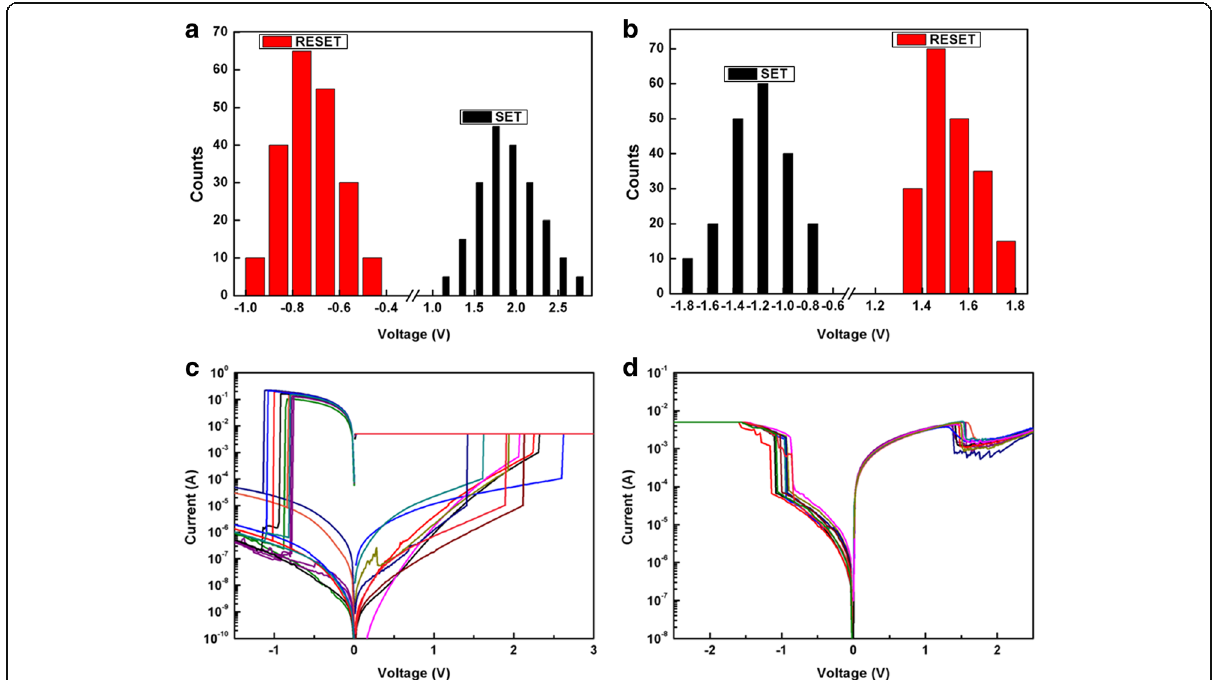
Fig. 3 The statistical results of distribution of the set and reset voltages measured from a single device unit for 200 times tests. a Pt/HfO 2 /TiO 2 / HfO